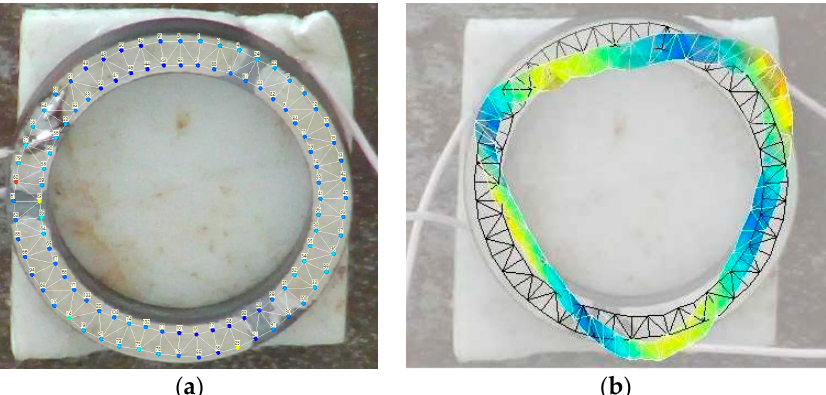
Figure 10. Prototype transducer ( a ) and measuredvibration shape of the transducer at the frequency of 91.6 kHz; ( b ) measured shape of the transducer vibrations.